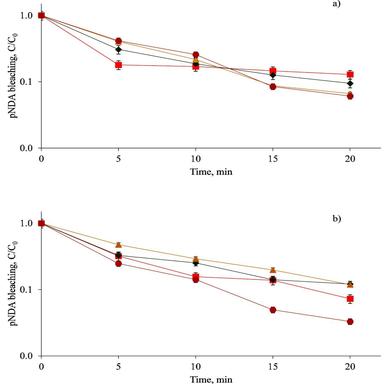
pNDA bleaching using different zeolite materials—(■)Fe1.0HAlBEA, (◆)Fe1.0SiBEA, (●)Fe4.0HAlBEA, and (▴)Fe4.0SiBEA—at a zeolite loading of 160 mg L− 1 and UV radiation with a) 0 and b) 50 mM hydrogen peroxide.